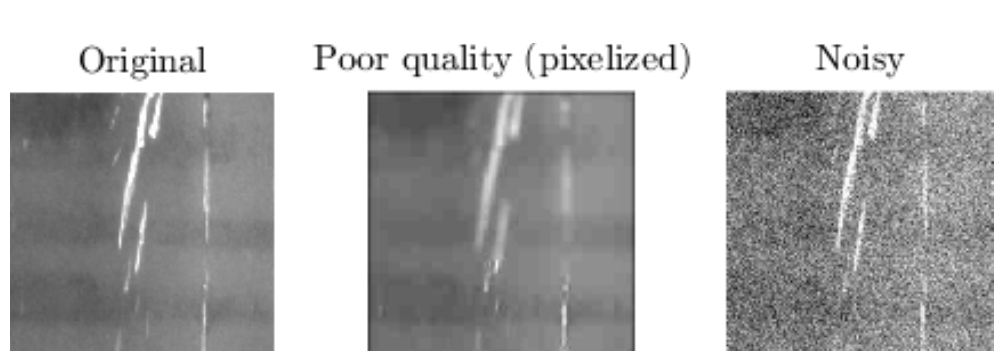
Figure 10. Original and artificial source images to compare and see the effect of fusion and calculate evaluation metrics over the images from